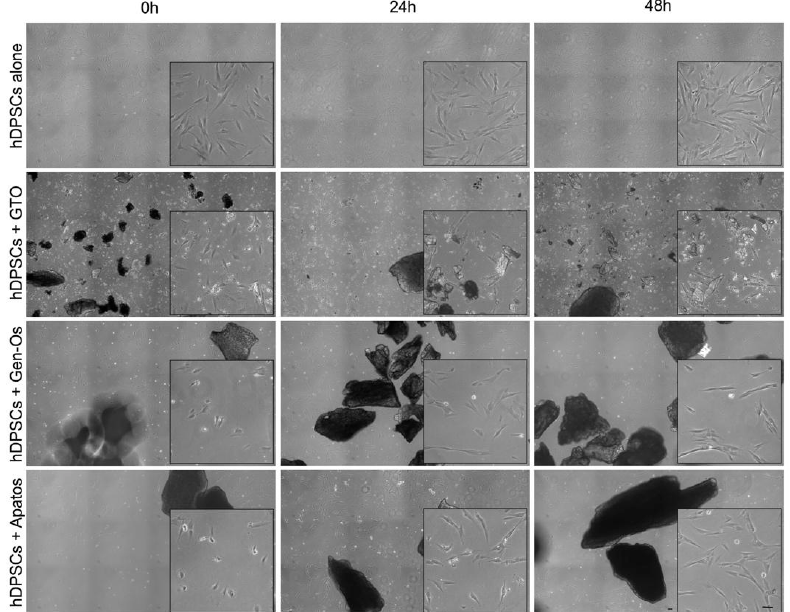
Figure 1. Morphological analysis of hDPSCs after BSBs treatment. Representative phase contrast grab images showing hDPSCs adhesion and morphology after 0, 24, and 48 h of BSBs treatment. High-magnification images are reported in black squares. Scale bar: 20 µ m. The immuno-labelling with phalloidin, showing the organization of actin filaments, h of BSBs treatments (Figure 2A).